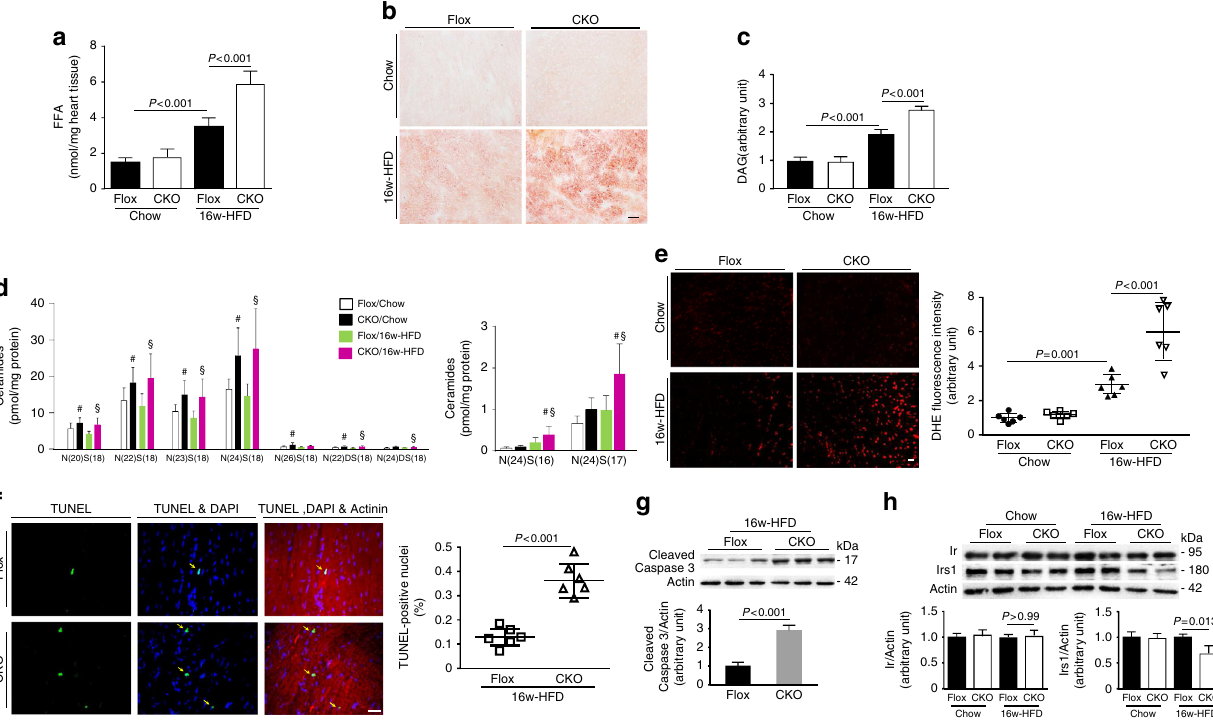
Fig. 4 Loss of Erk5 caused cellular injury in lipids overloaded hearts. a FFA extracted from heart tissues, and b Heart sections stained with Oil Red O, indicated that neutral lipids were increased in HFD-CKO hearts ( scale bar : 20 μ m). c Measurement of DAG content demonstrated an accumulation of its level in HFD-CKO hearts. d Triple quadrupole mass spectrometer analysis of ceramide species showed an altered ceramide species pro fi le in CKO hearts. # P < 0.05 vs. chow-Flox, § P < 0.05 vs. HFD-Flox, * P < 0.05 vs. chow-CKO, n = 7 mice per group. e DHE staining determined more superoxide generation in HFD-CKO hearts ( left panel , scale bar : 20 μ m). Fluorescence intensity was quanti fi ed ( right panel ). f TUNEL assay by triple staining with DAPI ( blue ), anti- α - actinin antibody ( red ), and TUNEL ( green ) detected apparent apoptosis in HFD-CKO hearts ( left panel , scale bar : 20 μ m), arrows indicated TUNEL positive nuclei. The quanti fi cation of TUNEL positive nuclei is shown in bar graphs ( right panel ), n = 6 mice per group. g Immunoblot analysis showed increased active caspase-3 in the hearts of HFD-CKO mice. The quanti fi cations are represented by the bar graphs. h Immunoblot analysis showed decreased Irs1 in HFD-CKO hearts. The quanti fi cation is represented by the bar graphs, n = 6 mice. Actin is the protein loading control. Data are presented as means ±